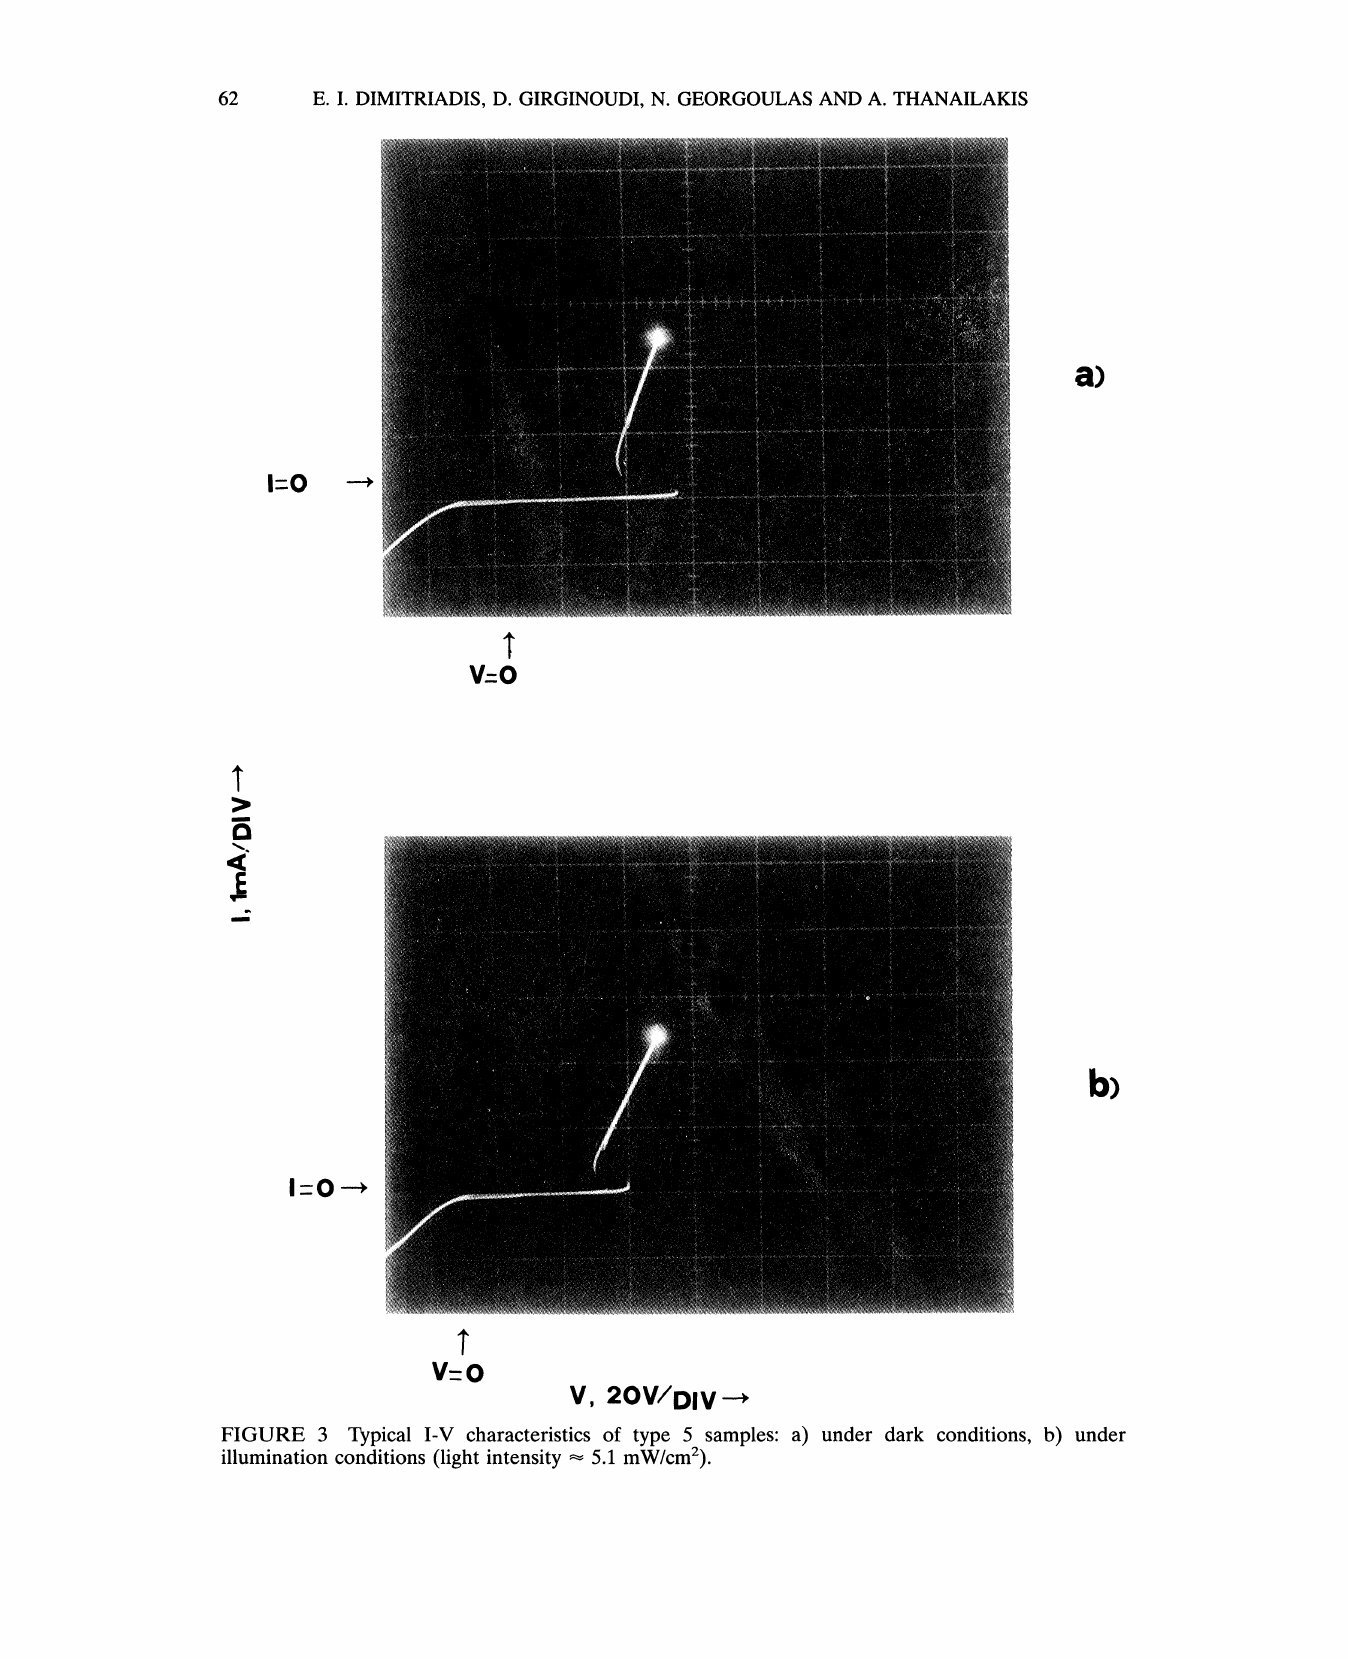
FIGURE 3 Typical I-V characteristics of type 5 samples: a) under dark conditions, b) under illumination conditions (light intensity 5.1